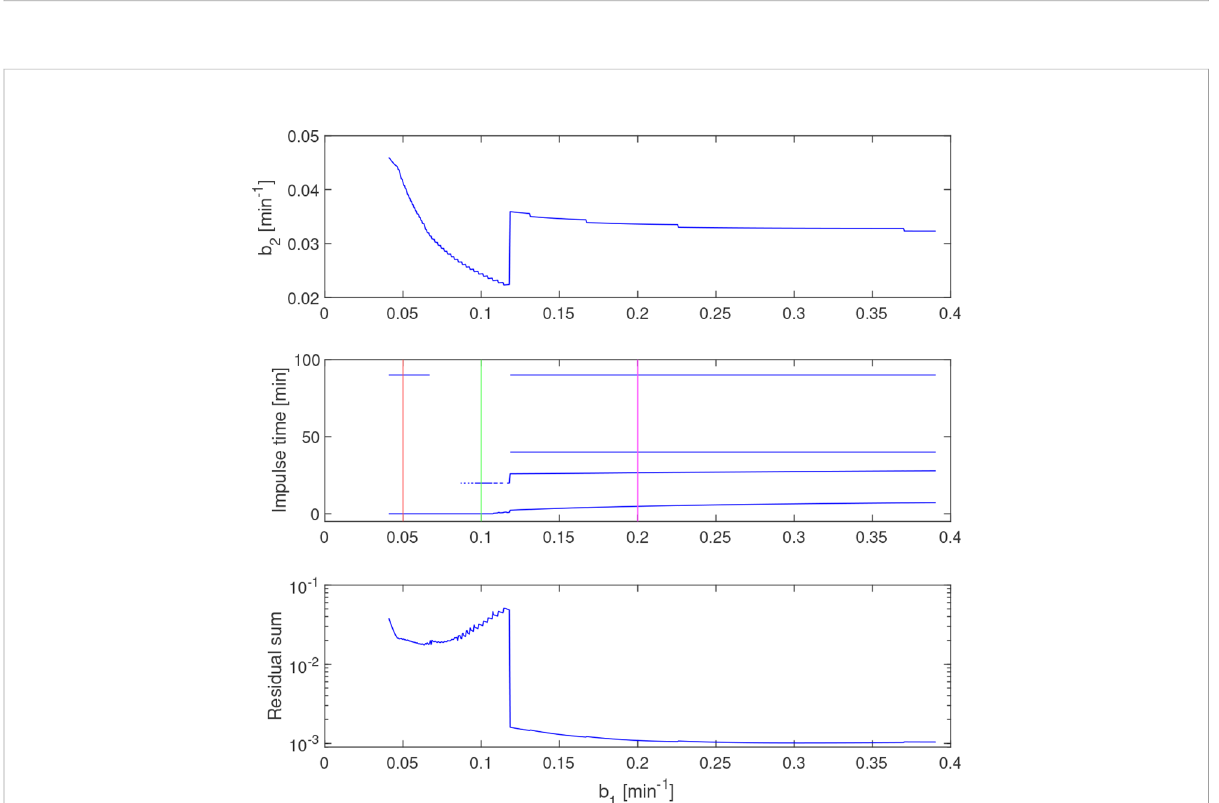
FIGURE 6 Estimated ^ g P (top) and impulse times (middle) and residual sum of squares (bottom) along the curve ^ g P . Vertical lines (red and green) correspond to the simulated concentrations in Figure 7. The discontinuity of ^ g P coincides with the introduction of a fourth estimated impulse, which also reduces the residual sum.